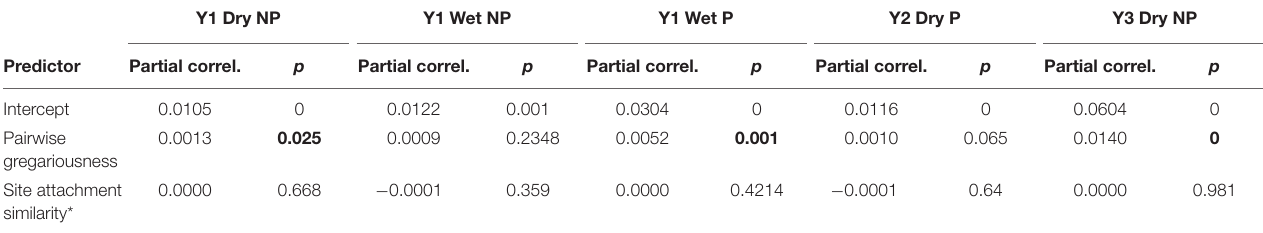
TABLE 3 | Matrix regression of non-social predator variables on association matrices across the five non-random